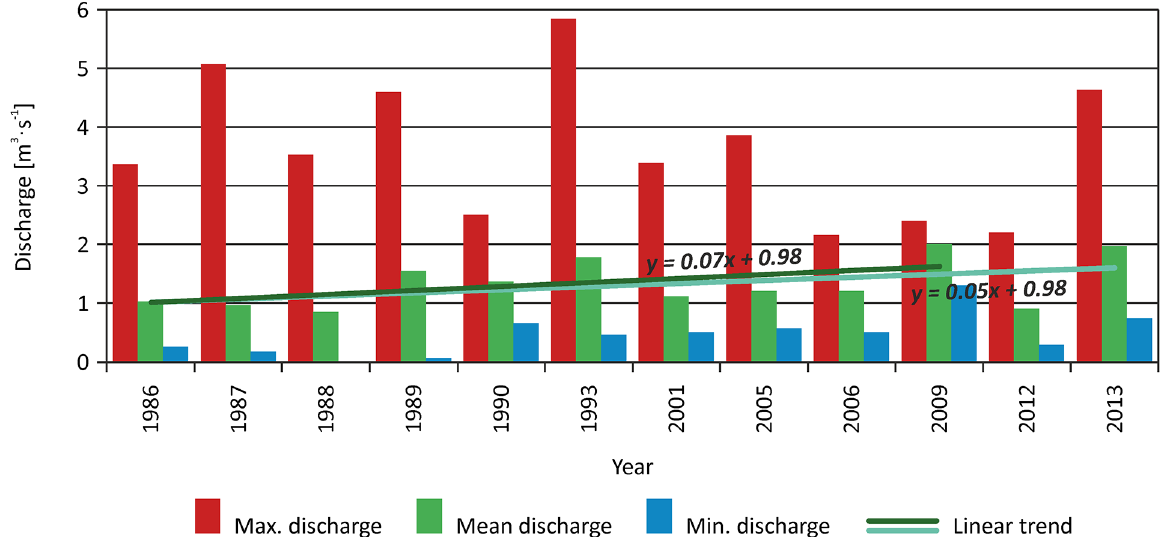
Fig. 7. Mean seasonal discharges in the Scott River in comparison to maximum and minimum discharges in the years